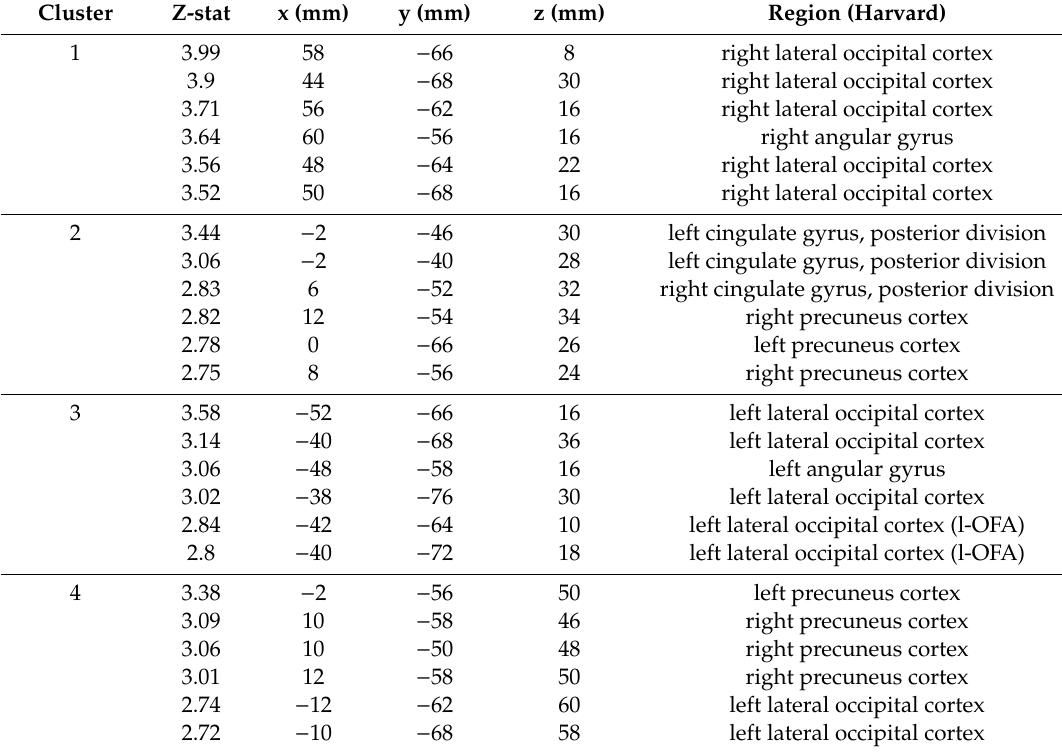
Figure 3. Cismen vs. transwomen. Between-group analysis during the face presentation (female → male) shows clusters of significantly ( p <0.01) higher blood oxygen level dependent (BOLD) effect in transwomen group when compared with cismen. They include bilaterally the precuneus, the posterior cingulate gyrus, the angular gyrus and the lateral occipital cortices (including the occipital face area). Coordinates are reported in Montreal Neurological Institute space. Table 3. Clusters of significantly ( p <0.01) higher differential activation in the transwomen group when compared with cismen for female → male face contrast.